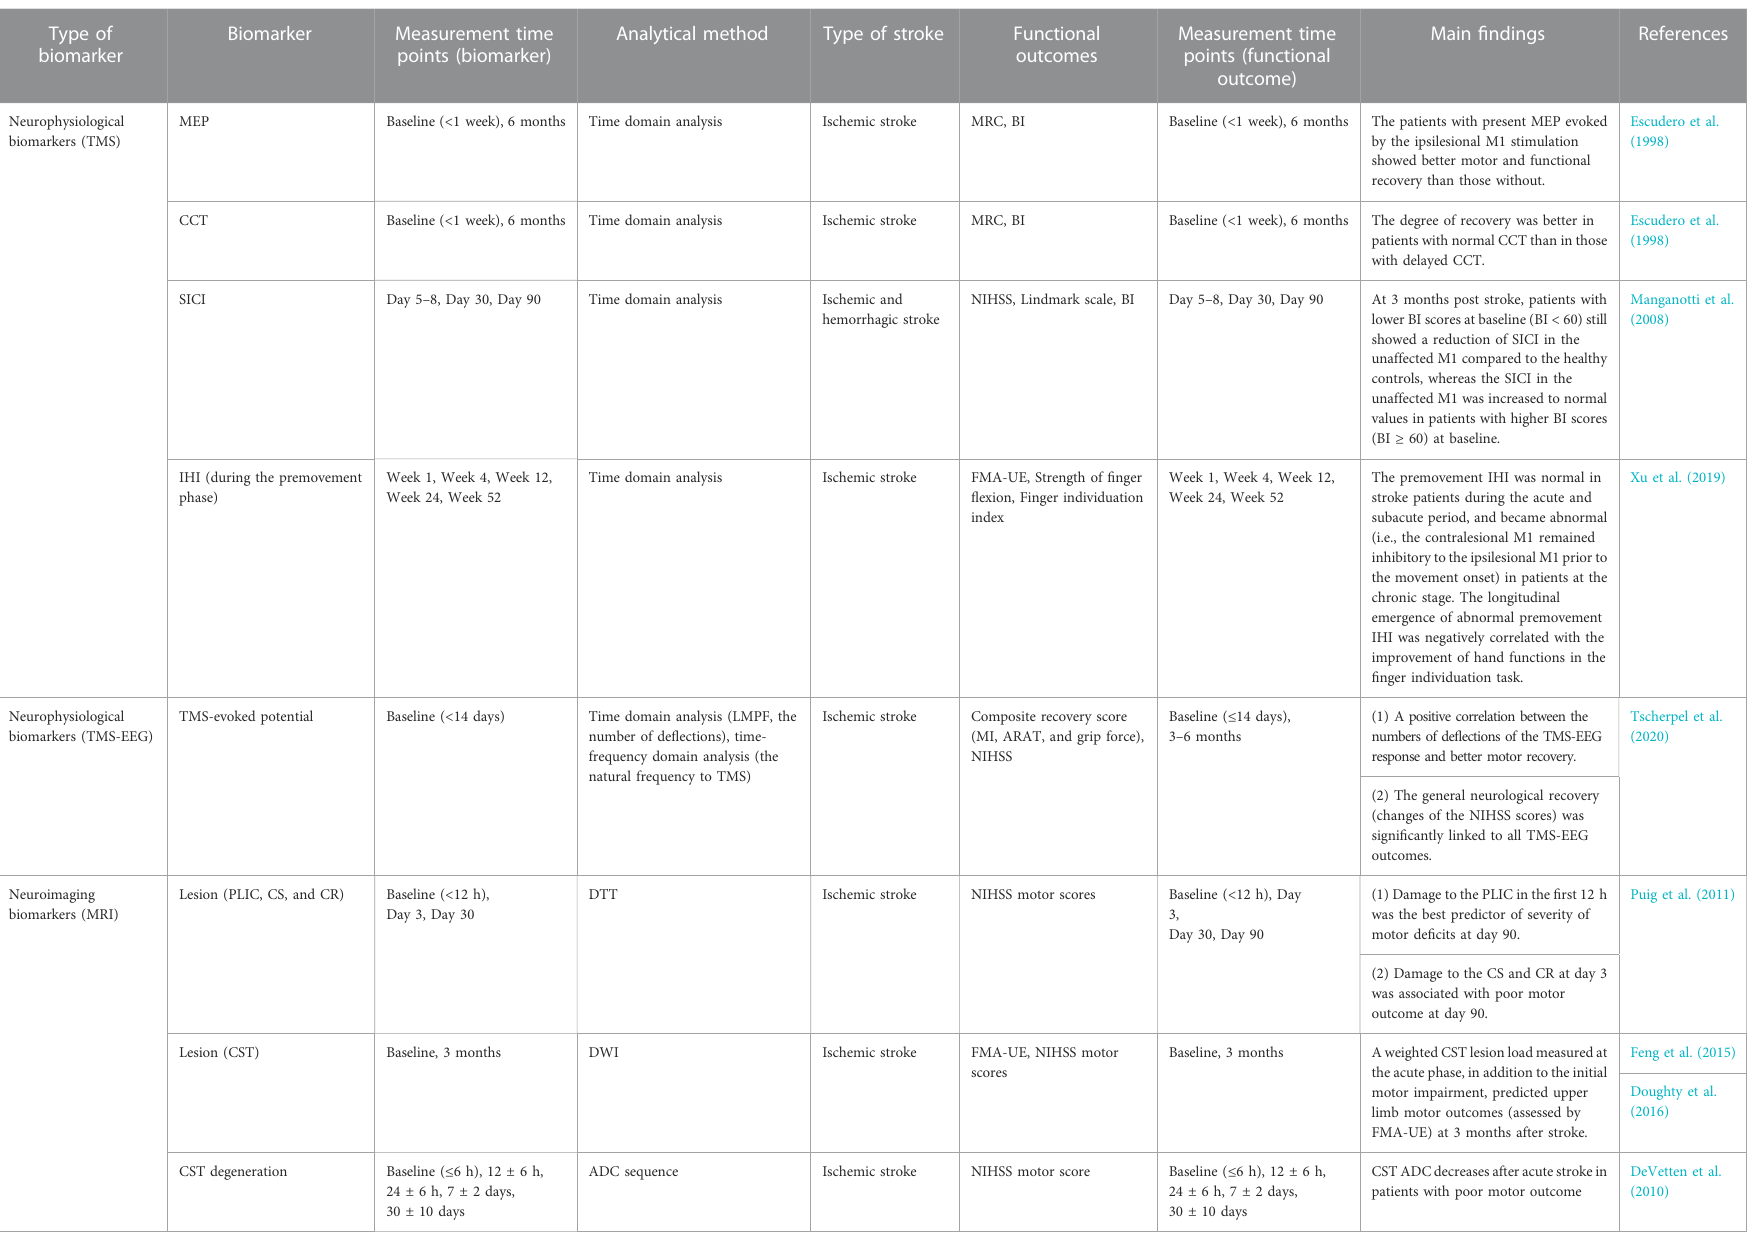
TABLE 1 ( Continued ) Neurophysiological and neuroimaging biomarkers for stroke prognosis.